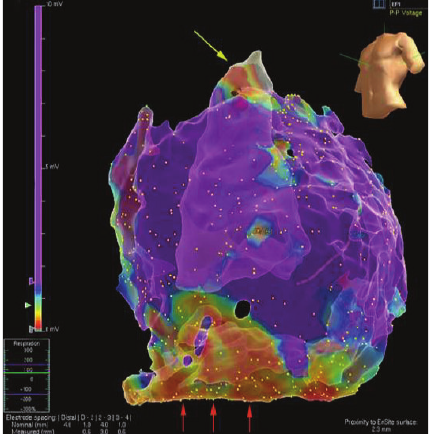
Figure 3: Epicardial electroanatomic mapping of the right ventricle. Bipolar mapping of the epicardial surface shows a small area of fibrotic tissue in the distal RVOT (yellow arrow) and a larger area of fibrotic tissue involving inferolateral free wall of the right ventricle (red